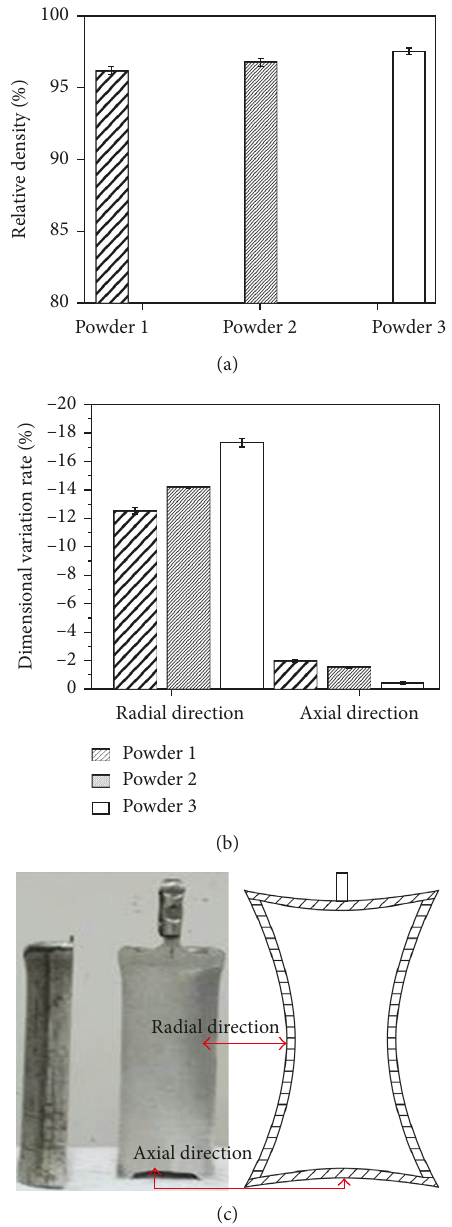
Figure 2: The relative density (a), the radial and axial dimensional variation rate (b), and the radial and axial direction dimensional measurement position